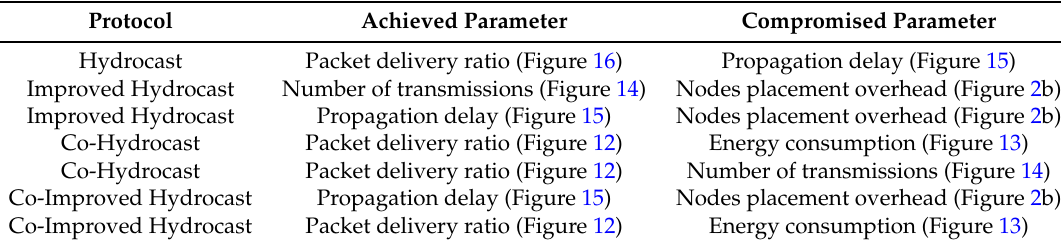
Table 3. Performance trade-offs made by the